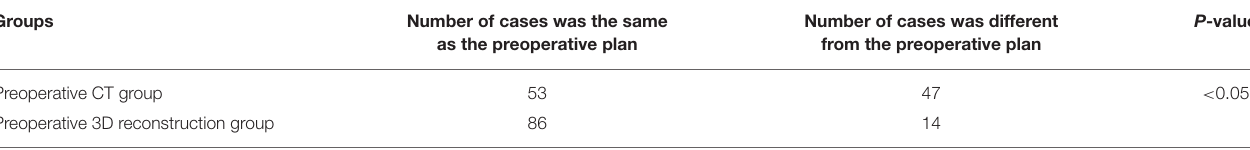
TABLE 2 | The compliance rate of the surgical plan between the preoperative CT group and the preoperative three-dimensional reconstruction group. Groups